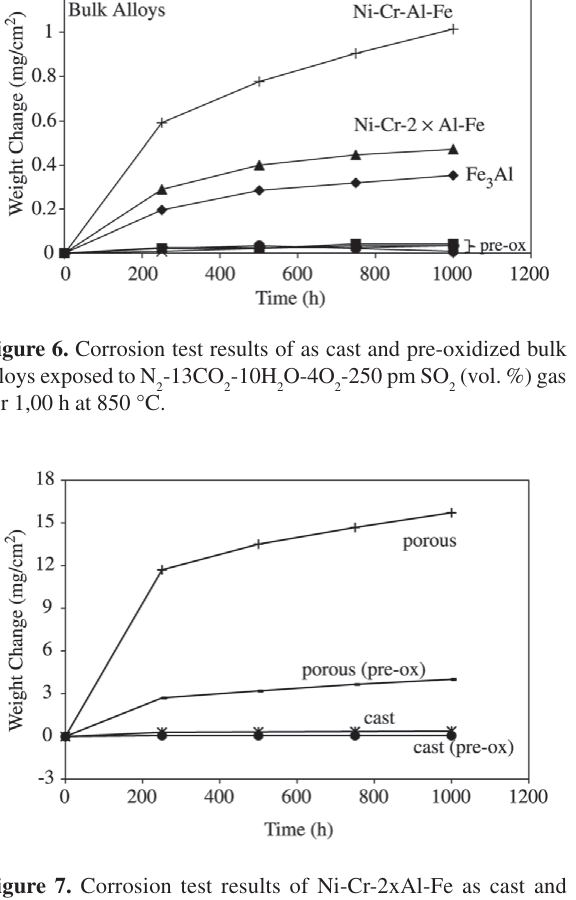
-13CO -10H O-4O -250 ppm SO 2 2 2 2